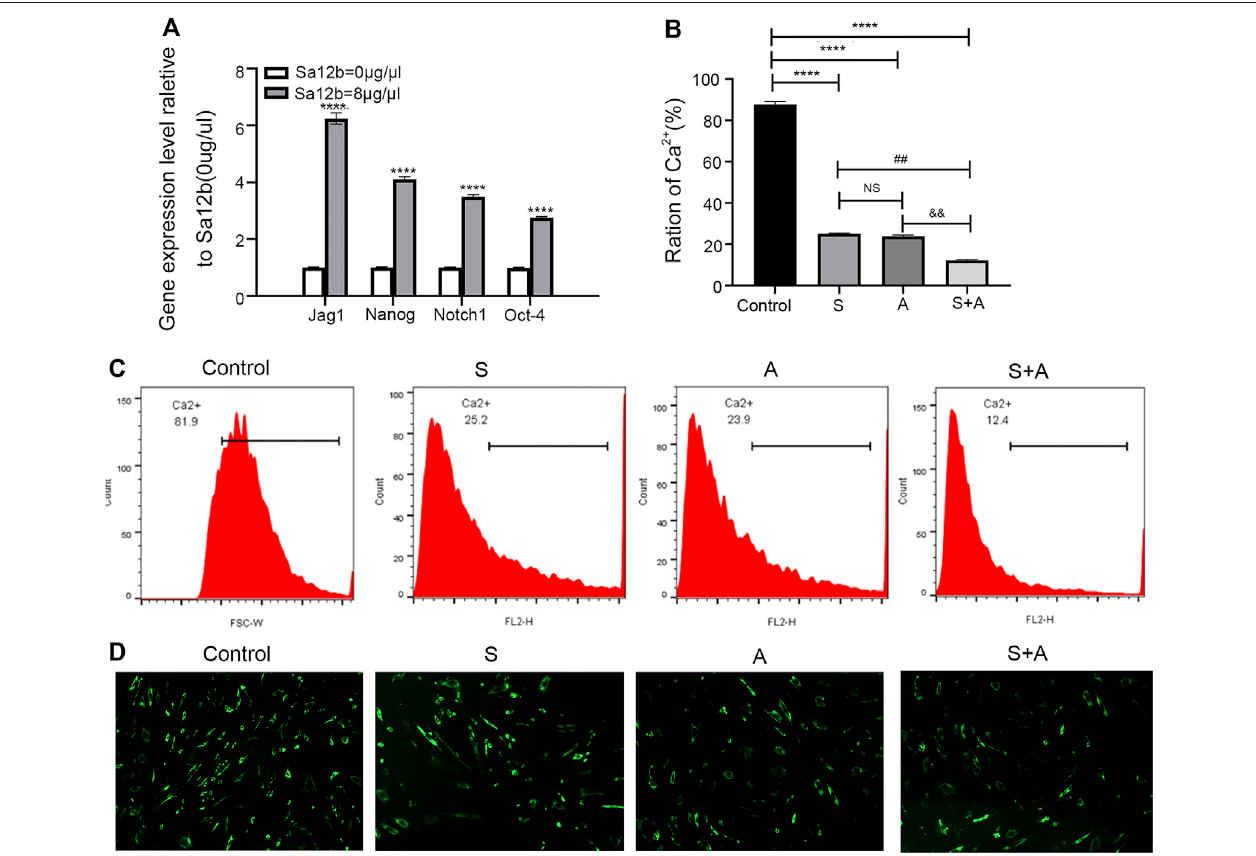
FIGURE 7 | Sa12b increased the expression of stem cell – related genes under acidic microenvironmental conditions and reduced the in fl ux of calcium ions in NP- MSCs by inhibiting ASICs. (A) In an acidic environment, the optimal concentration of Sa12b was applied to NP-MSCs, and the expression of stem cell – related genes (Jag1, Nanog, Notch1, and Oct4) was signi fi cantly higher than that in the control group ( p < 0.001). ****indicates p < 0.0001 when the control group ( Sa12b = 0 μ g/ μ l) was compared with the other groups; NS indicates no statistical signi fi cance when the Sa12b treatment compared with the group with amiloride. ## indicates p < 0.01 when the Sa12b treatment ( Sa12b = 8 μ g/ μ l) compared with the group with amiloride and Sa12b. && indicates p < 0.01 when the Sa12b group compared with the amilorideandSa12btreatment. (B) TheCa 2+ concentrationinthetreatmentgroups(Sa12b,amiloride,andcombinedSa12b/amiloride)waslowerthanthatinthecontrol group according to the results of fl ow cytometry. Furthermore, the Ca 2+ concentration in the group administered Sa12b and amiloride simultaneously was signi fi cantly lower than that in the control group. (C) Ca 2+ concentration was measured by fl ow cytometry. (D) Confocal laser scanning microscopy imaging analysis of Ca 2+ concentration. * p < 0.05, ** p < 0.01, *** p <